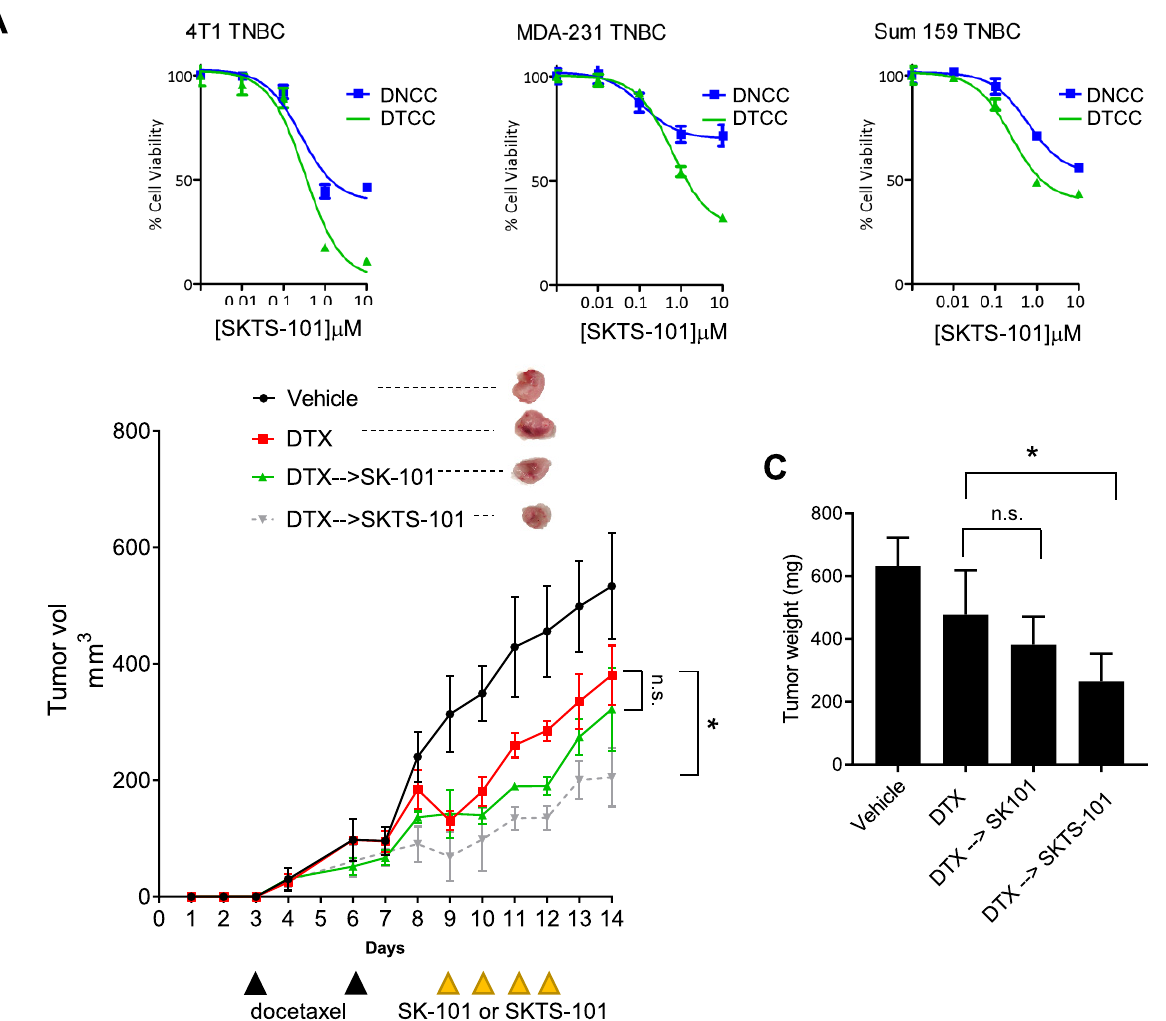
Figure 3: Validation of the efficacy of the novel lipid-drug conjugate in vitro and in vivo : (A) Cell viability analysis of SKTS-101 comparing efficacy in DTCCs and DNCCs from three different TNBC cell lines (4T1, MDA-MB-231 and SUM-159). (B) Tumor growth curve in 4T1 mammary carcinoma model with heterotopic implantation. The data are represented as mean ± SEM and statical analysis has been performed following unpaired t-test between the indicated groups on day 14. The upper inset shows representative images of the isolated tumors following sacri fi ce of the mice on day 14. N = 4 per group. (C) Bar plot showing the tumor mass comparing the tumor growth amongst the vehicle, DTX treated, SK-101 treated and the conjugated (SKTS-101) treated mice groups. The data represented as mean ± SEM and statical analysis has been performed following one-way ANOVA with a Dunnett ’ s multiple comparison test, where * p <